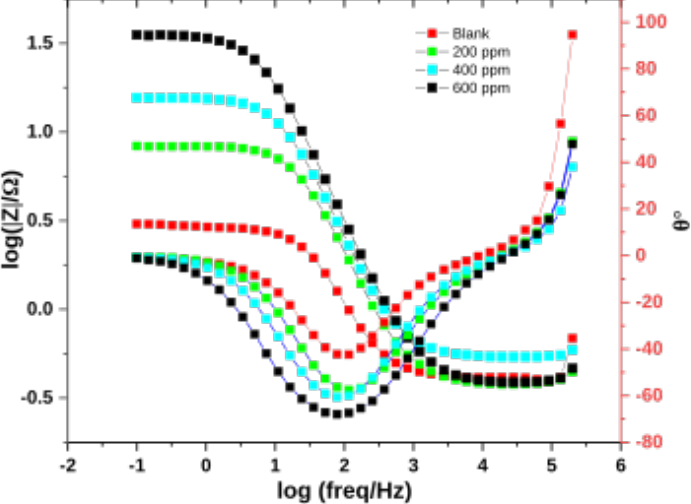
Figure 10. Bode plot of mild steel in 1 M HCl at different concentrations of PBSLP with the sinusoidal potential of 5 mV.